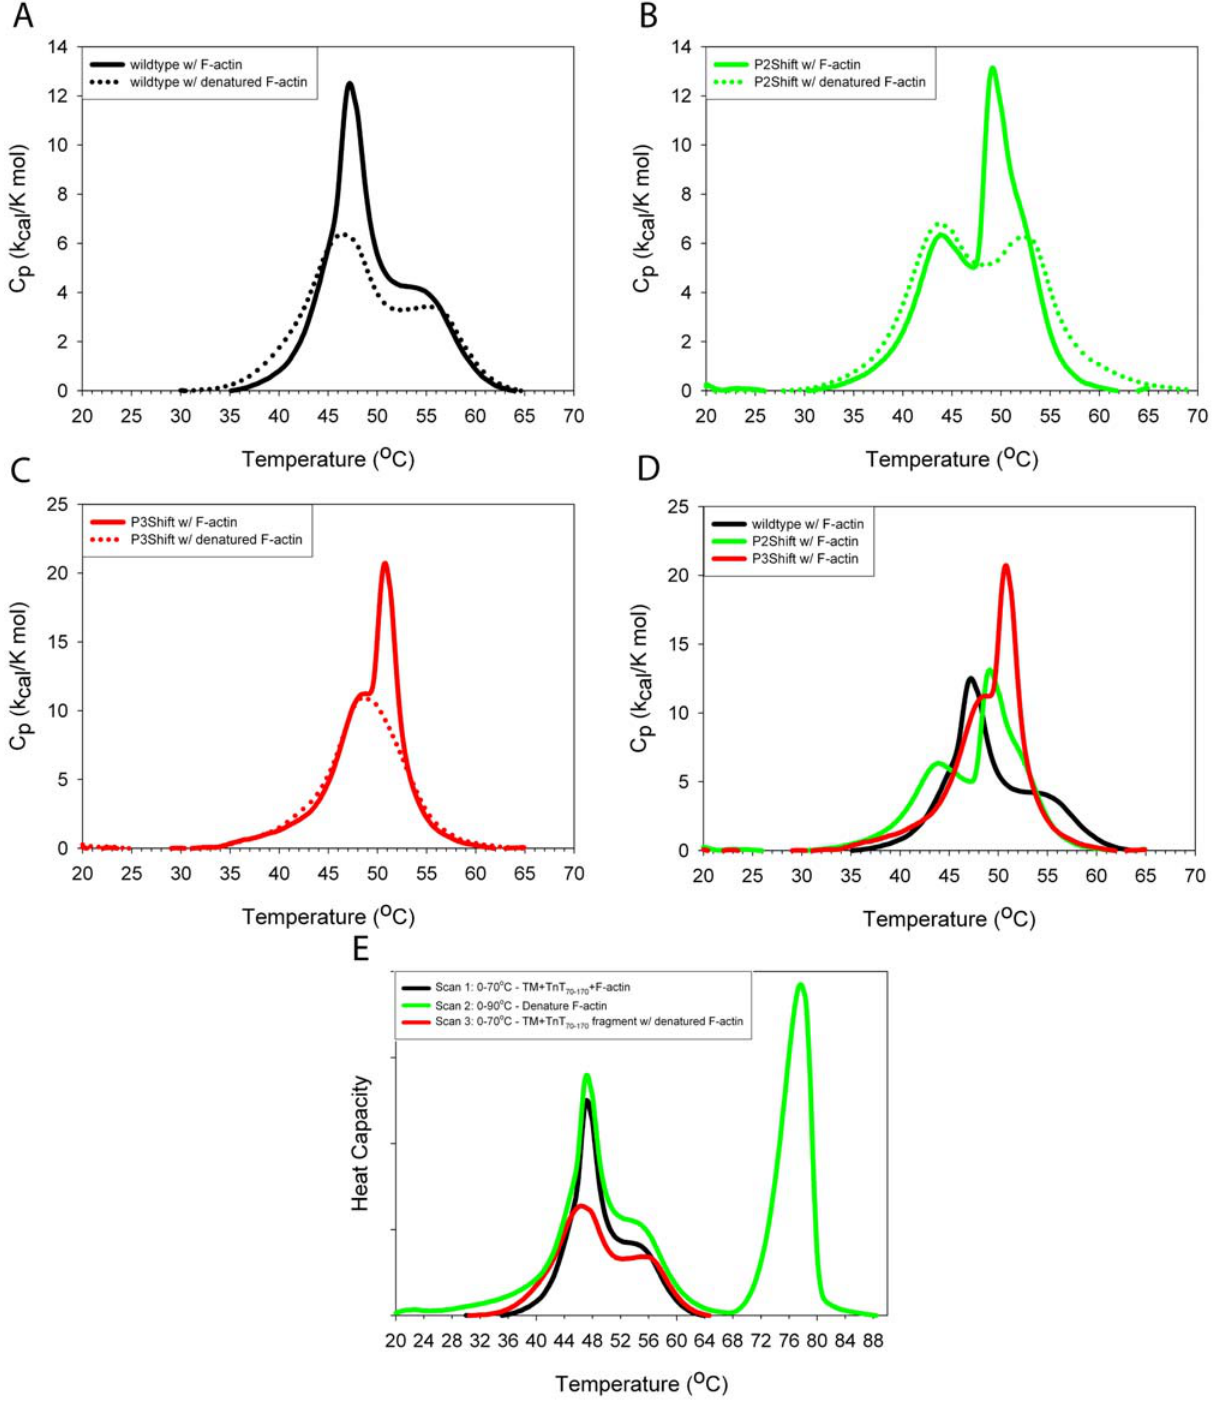
Figure 3. DSC scans of single cluster shift mutants with TnT 70–170 in the presence and absence of F-actin. Tropomyosin (15 m M) and TnT 70–170 (18 m M) were mixed with phalloidin (36 m M) stabilized F-actin (24 m M) in 100 mM NaCl, 10 mM Hepes pH 7.0, 2 mM MgCl 2 , 1 mM DTT and heated as described in Materials and Methods. The second (with F-actin-solid lines) and third (post-F-actin denaturation-dotted lines, TM- TnT 70–170 ) scans are shown. A. wildtype (black); B. P2Shift (green); C. P3Shift (red); D. Combination of A-C in the presence of F-actin with the color scheme as indicated in A-C. The P2Shift and P3Shift mutants bind F-actin with higher affinity than wildtype. E. Experimental procedure: An excess of unacetylated recombinant tropomyosins and the TnT 70–170 fragment was added to phalloidin-stabilized F-actin and the sample was heated a total of three times. An excess was added to ensure maximal binding of tropomyosin. The experiments were done in the presence of TnT 70–170 because unacetylated tropomyosin binds poorly to F-actin. First, the sample was heated from 0–70 u C (black line) and then cooled. This curve shows the dissociation of tropomyosin from F-actin (main peak) and the unfolding of TM-TnT 70–170 . Second, the sample was heated to 90 u C (green line) to denature the F-actin and subsequently cooled. In the third scan (magenta line), post-F-actin denaturation, the sample was heated to 70 u C and only the TM + TnT 70–170 signal is present. The first two scans are similar, and mark the tropomyosin unfolding/dissociation thermal peak, consistent with previously published results [22,24,62]. The thermal unfolding of tropomyosin is almost completely reversible, while F-actin denaturation is irreversible.